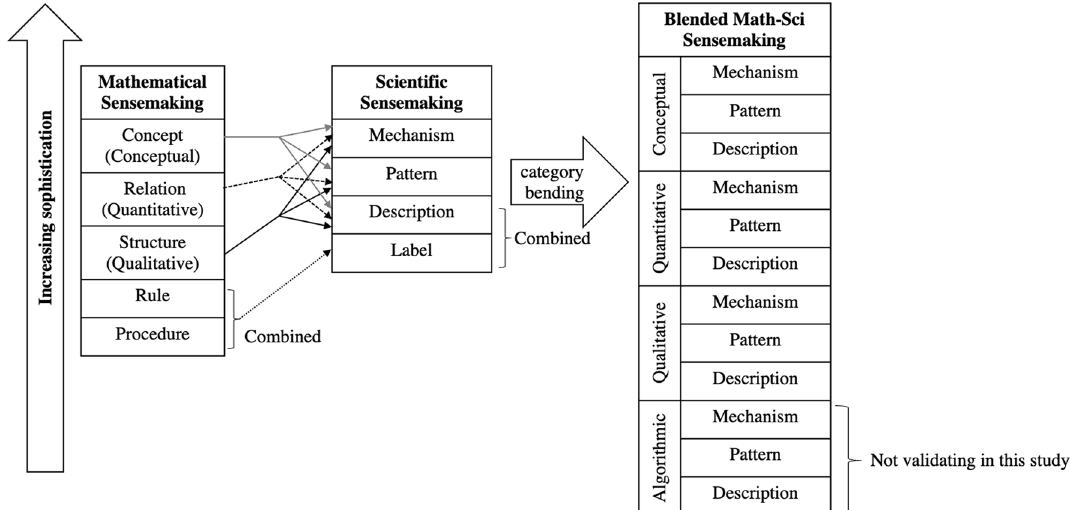
Fig. 1 Science and Mathematics categories of Zhao and Schuchardt (2021) blended into new categories making up the blended Math-Sci